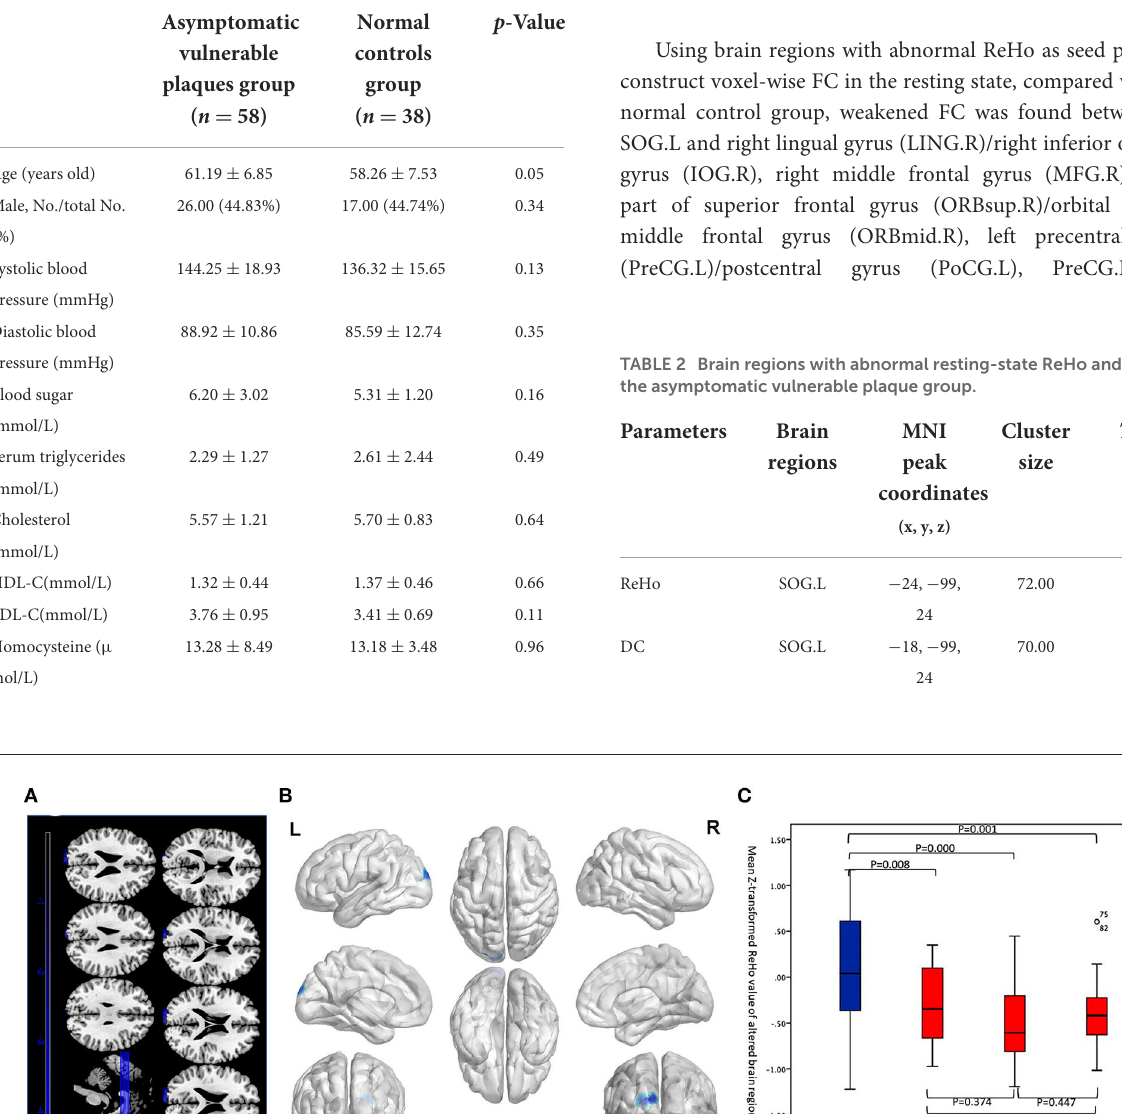
Table 2). The left, right, and bilateral vulnerable plaque groups showed no statistically significant differences in DC ( p < 0.05,